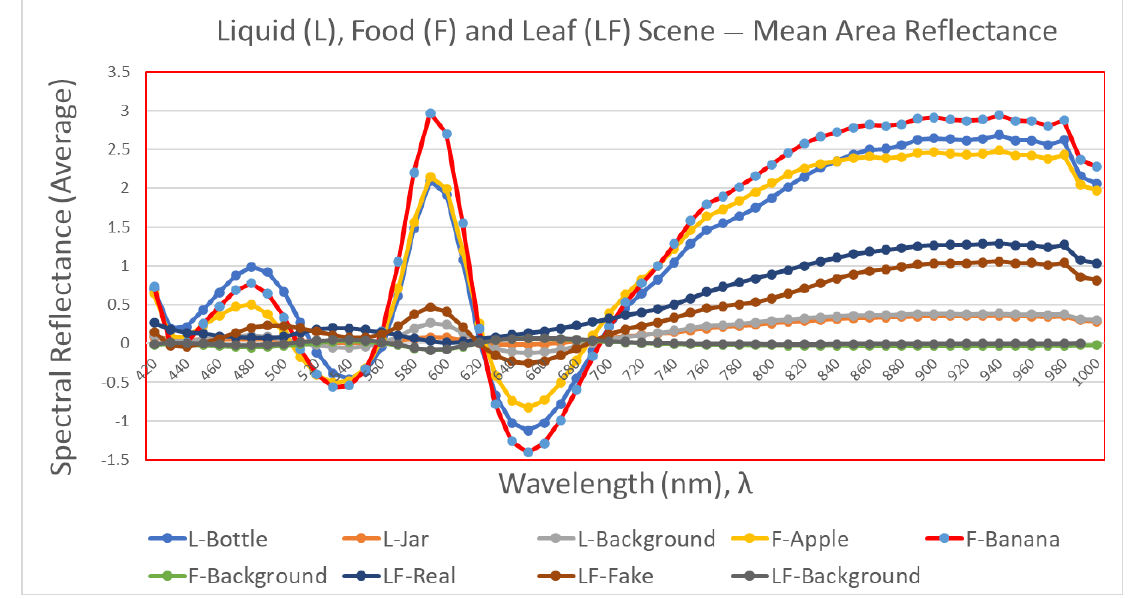
Figure 2. Multiband mean spectral reflectance measurements of the three scenes.